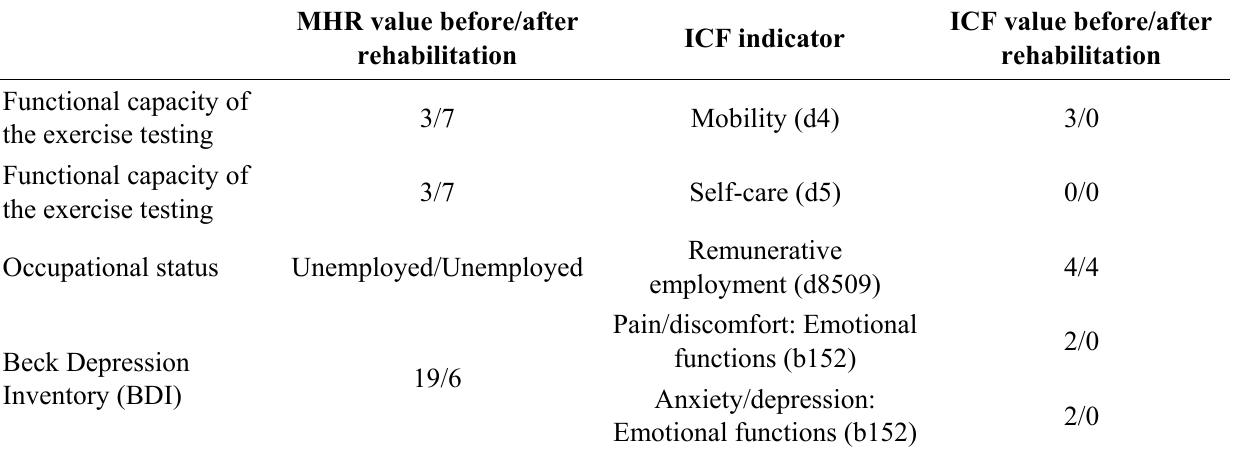
Table 4. Pedro’s case: 77-year-old man who participates in motor and sexual rehabilitation processes (walking and sexual treatment) during 123